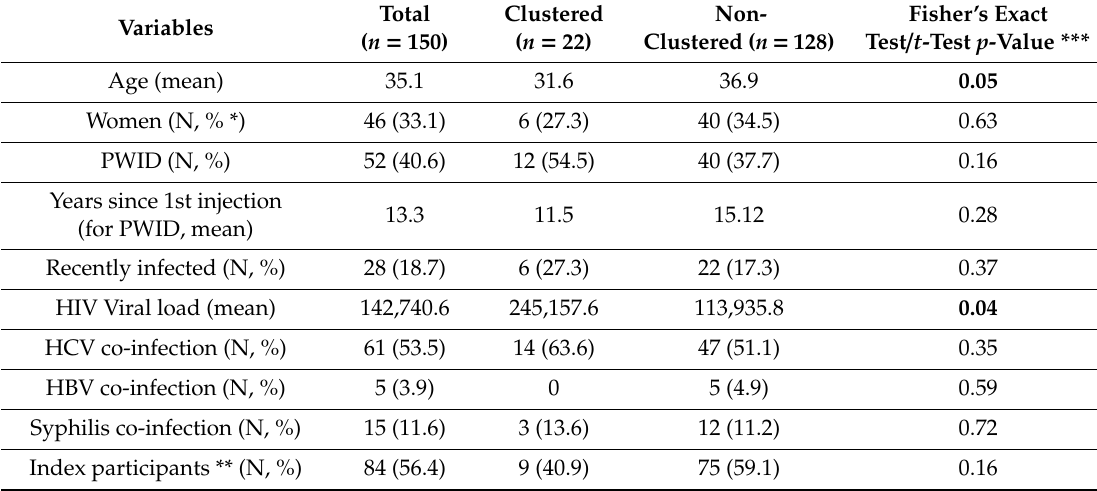
Table 1. Characteristics associated with the HIV sequences collected within the Transmission Reduction Intervention Project (TRIP) intervention.